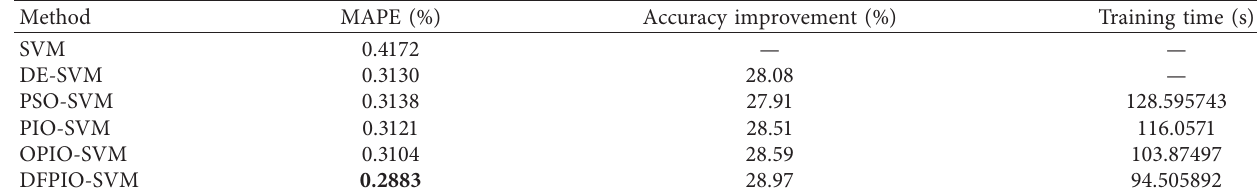
Table 3: Comparison of prediction accuracy for the temperature of PV